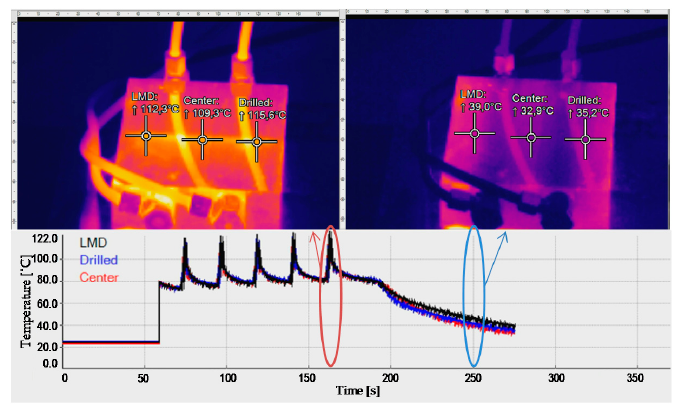
Figure 8. Cooling capacity when the water-cooling is active after reaching 100 °C.